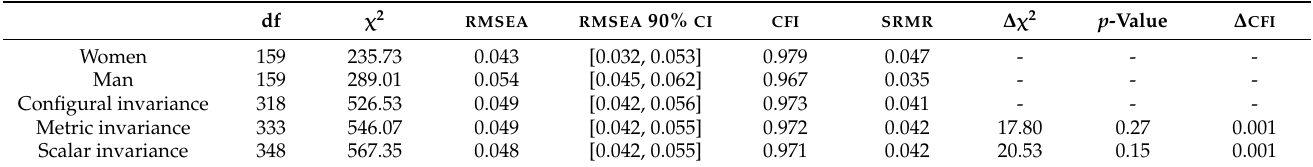
Table 5. SAPH@W invariance across gender: model